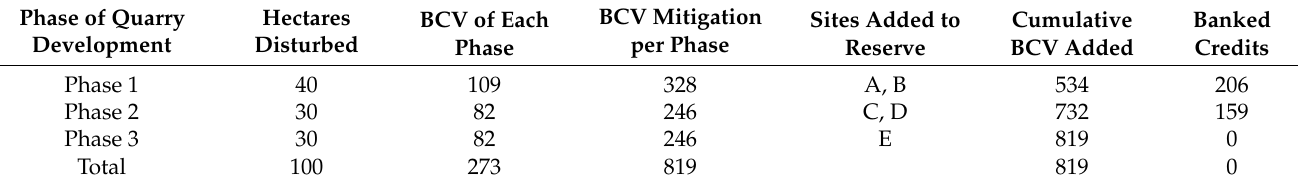
Table 2. Five hypothetical reserve contributions used as incremental mitigation credit for three phases of a proposed quarry, expressed in bighorn conservation units ( bcu ).